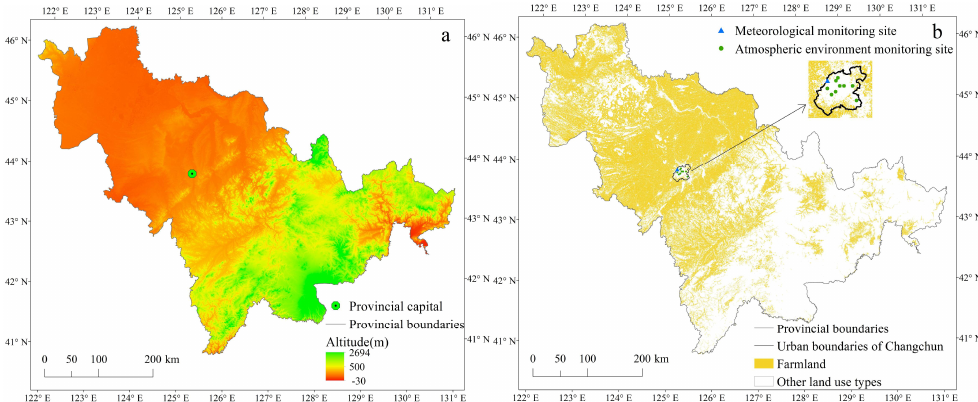
Figure 1. Topography ( a ) and farmland distribution ( b ) in Jilin Province. The inset is the urban area of Changchun and its atmospheric environmental and meteorological ground-monitoring